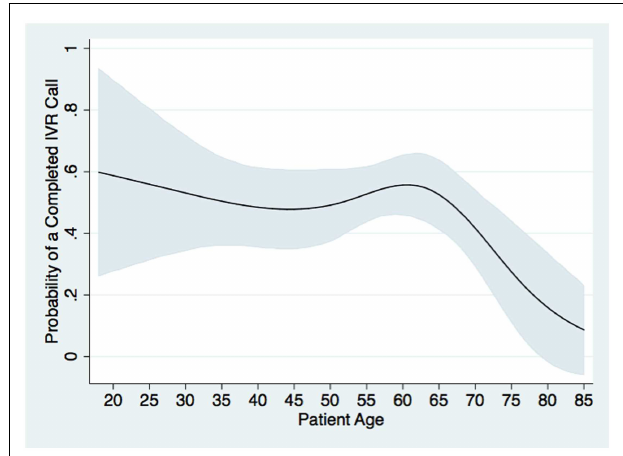
FIGURE 1 | Probability of completing a given weekly IVR monitoring and self-management support call ( Y axis) by patient age ( X axis) is shown . Probabilities were estimated from a two-level multivariable logistic model in which the outcome of each patient-week of call attempts was analyzed, with call weeks nested within patient, and controlling for patients’ baseline sociodemographic, clinical, and access characteristics as shown in Table 1 . Gray bands represent 95% confidence intervals for the predicted probabilities.